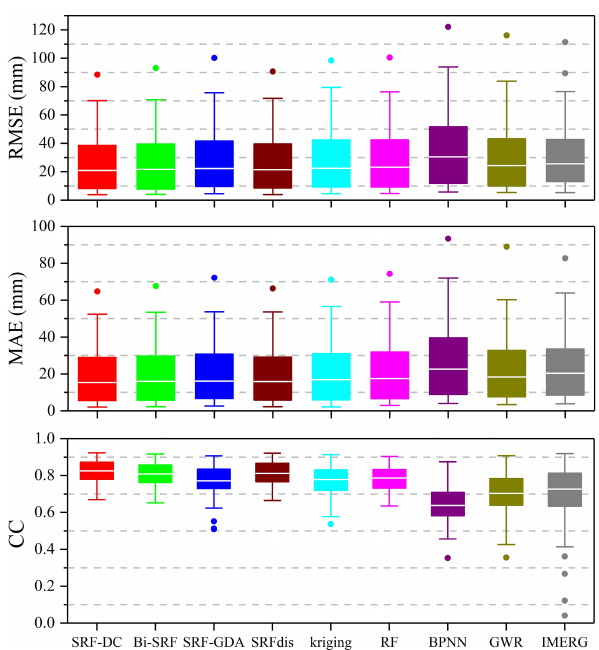
Figure 6. Boxplots of RMSE, MAE and CC values of all the meth- ods on a monthly scale during 2015–2019.